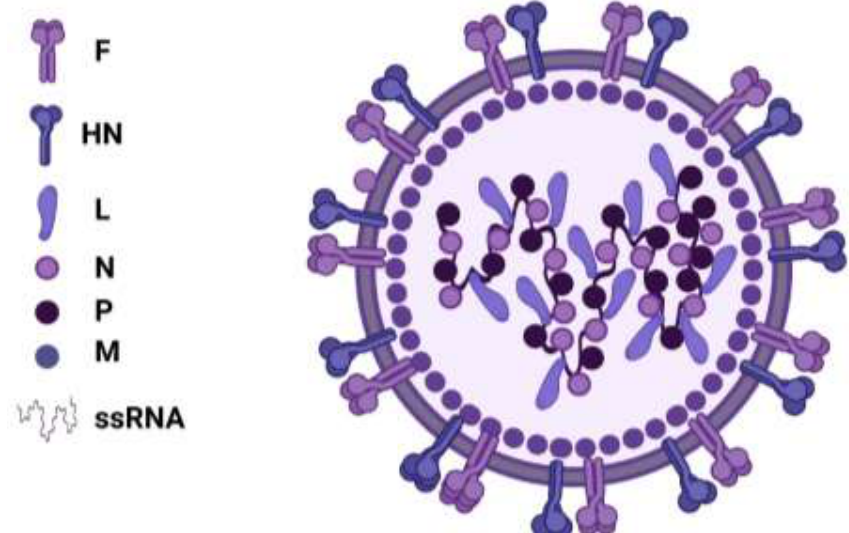
Figure 1: Schematic diagram of Newcastle disease virus structure. This figure was created using BioRender tools by the